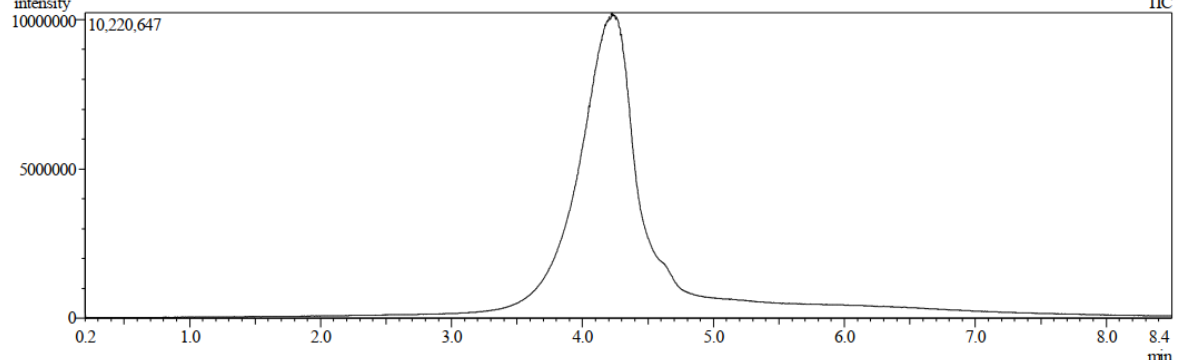
Figure 3. Direct injection probe mass spectrometer (DIP-MS) spectrum of 7-geranyloxycinnamic. Using electron spray ionization (ESI) and liquid chromatography mass spectrometry (LC-MS), which produced a m / z 301.1776 [M + H] (Figure 4), the identification of the pure compound isolated was further validated and it was similar to the data previously reported by Hashim et al. (2005). From our findings and based on the previously reported reference Molecules 2023 , 28 , x FOR PEER REVIEW spectral data (Table 2), the compound was determined to be 7-geranyloxycinnamic acid.